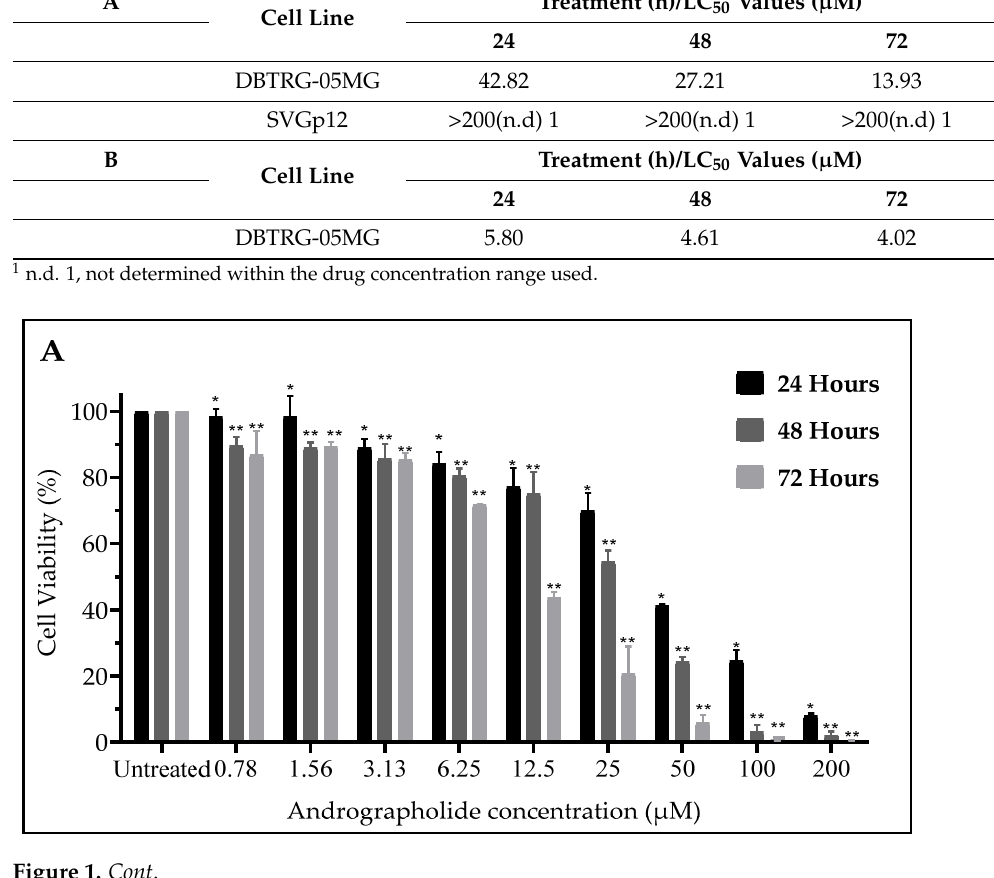
Table 1. The half-maximal lethal concentration (LC 50 ) values for ( A ) DBTRG-05MG and SVGp12 cells after being treated with andrographolide (0.781–200 µ M) and ( B ) DBTRG-05MG cells after being treated with temozolomide (0.781–200 µ M) were estimated using nonlinear regression approximations in GraphPad Prism 8.0.1 (Graphpad software, Inc., San Diego, CA, USA). A Cell Line